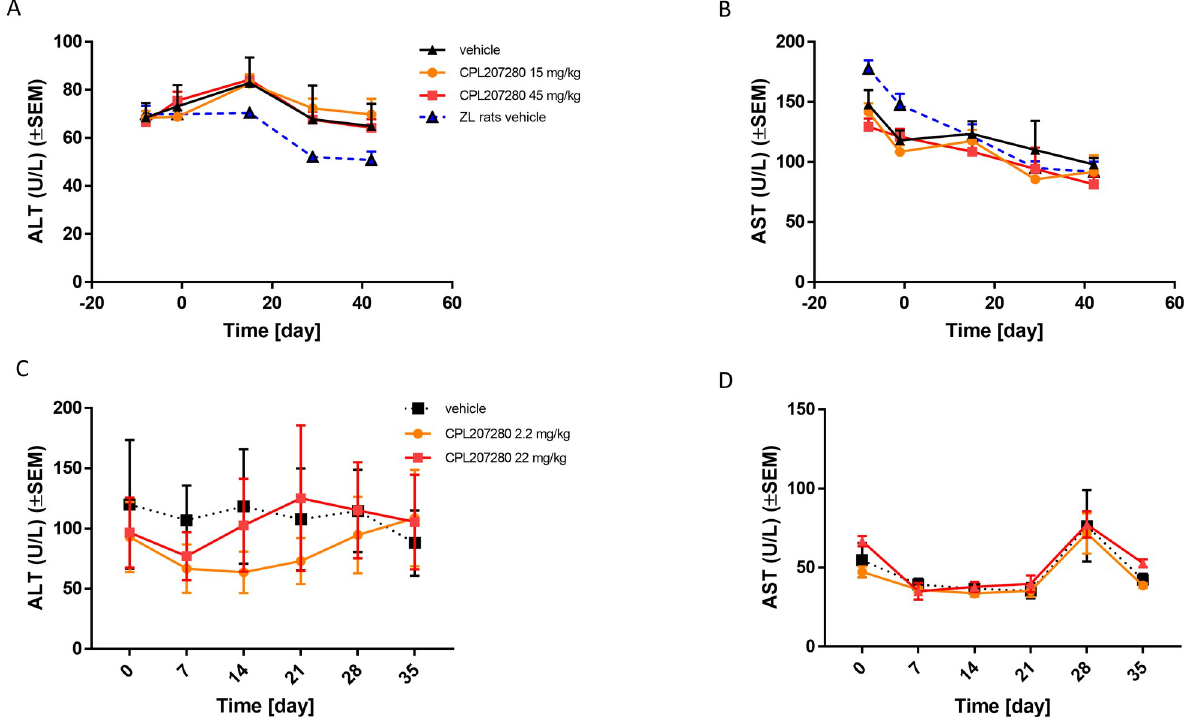
Fig 10. The effect of CPL207280 on liver toxicity markers in diabetic rats and monkeys. ZDF rats were treated with indicated doses for 42 days and serum was collected for ALT and AST analysis at different time points of the study (A, B). Diabetic cynomolgus monkeys were treated with indicated doses for 28 days followed by a 7-day wash-out (B). Serum was collected at different time points of the study for analysis of ALT and AST; Data are mean ± SEM; n = 8 for rats, n = 3 for monkeys.